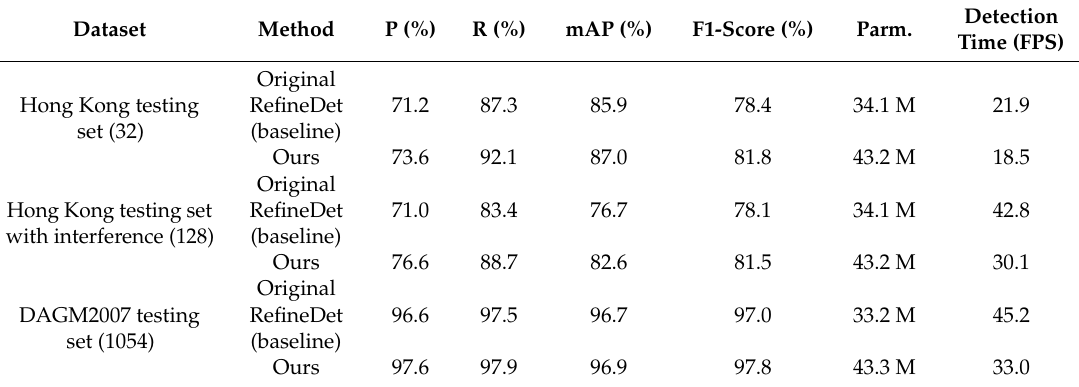
Figure 13. P-R curve display of the proposed method on the Hong Kong dataset and DAGM2007 dataset. ( a ) The P-R curve of the proposed method on Hong Kong testing set; ( b ) The P-R curve of the proposed method on Hong Kong testing set with interference; ( c ) The P-R curve of the proposed method on DAGM2007 testing set. Table 3. Performance results on Hong Kong dataset and DAGM2007 dataset